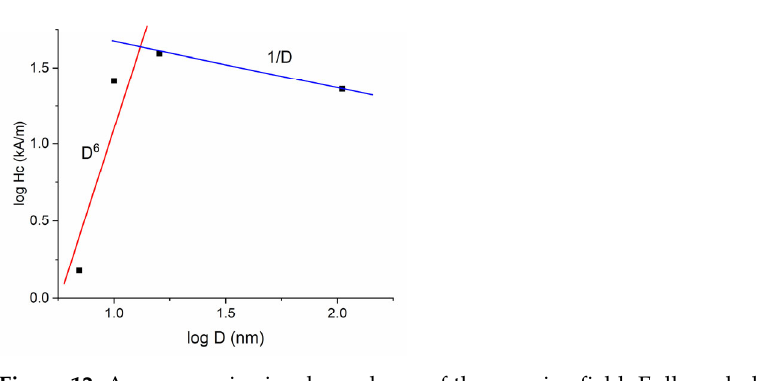
Figure 12. Average grain size dependence of the coercive field. Full symbols are the experimental values from Figure 11 plotted versus the average grain size in logarithmic scale. The linear fitting gives a D 6 dependence (red line) for samples annealed between 500 °C and 700 °C and a 1/D dependence (blue line) for annealing between 700 °C and 800 °C.